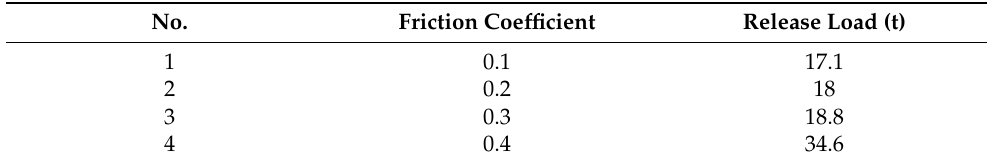
Table 1. Release load corresponding to different friction